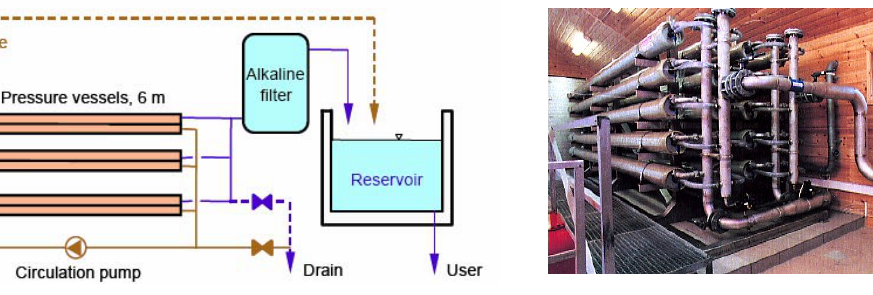
Fig. 1. Typical flow diagram and picture of a nanofiltration plant for NOM removal Figure 1. Typical flow diagram and picture of a nanofiltration plant for NOM Since the reduction of calcium and bicarbonate concentration through the membrane filter is about 15-30 %, an alkaline filter (calcium carbonate) is often included in order to increase the level of calcium and bicarbonate in the typically soft and corrosive Norwegian water.